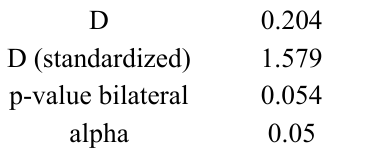
Table 12. Kolmogorov-Smirnov Test data fitting SIM_Exp_Lang .